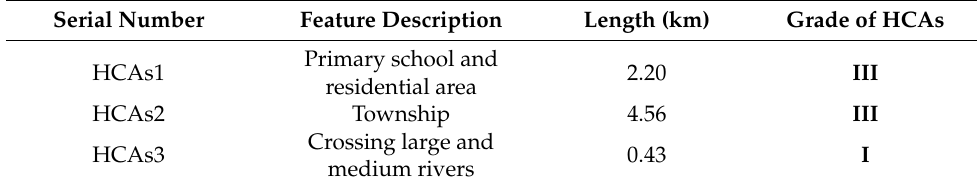
Table 5. Basic situation of